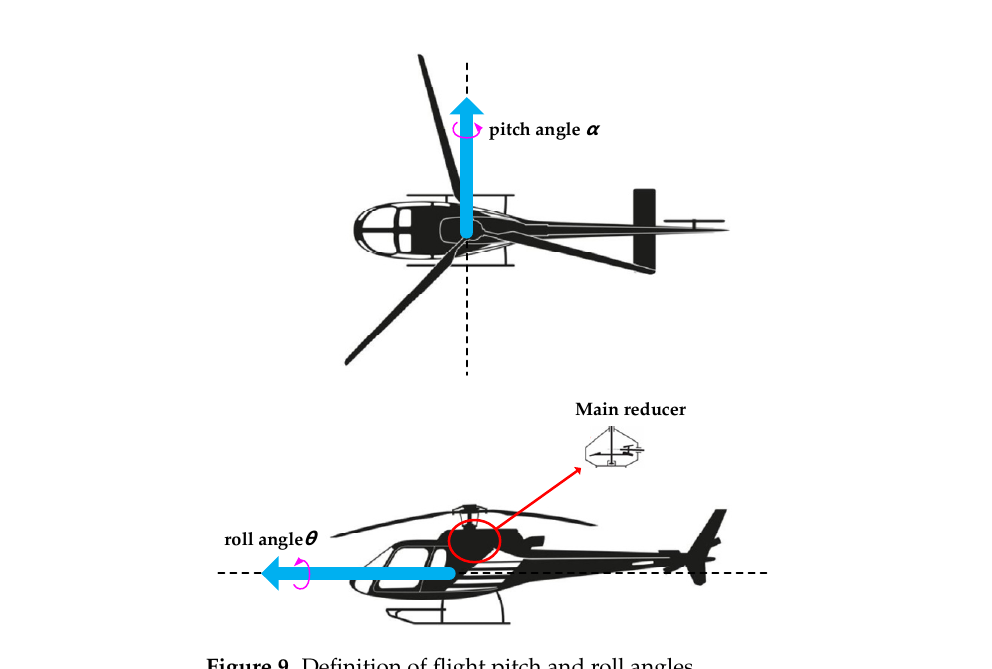
G 15° Figure 11. Cross-section of flow field distribution ( α = 15°, t = 1.5 s). The total amount of oil passing through Monitoring Plane 1 at different flight attitude angles is obtained as shown in Table 3. When the oil-guiding splash lubrication system is tilted to the spin-in side, the amount of oil splashed to the hollow cavity of the input shaft is outstanding larger than that of the non-spin-in side, namely, when the main shaft is rotated counterclockwise and the airframe is tilted to the positive direction of the pitch angle and the positive direction of the roll angle, the effective splashed oil amount is greater. Compared with the flight attitude of α = 0°, θ = 0°, the oil feed volume in the target area at α = 15°, θ = 0° and α = 0°, θ = 15° is closer to that in the level posture. In these three operating conditions, the oil-guiding cylinder is capable of providing sufficient oil for